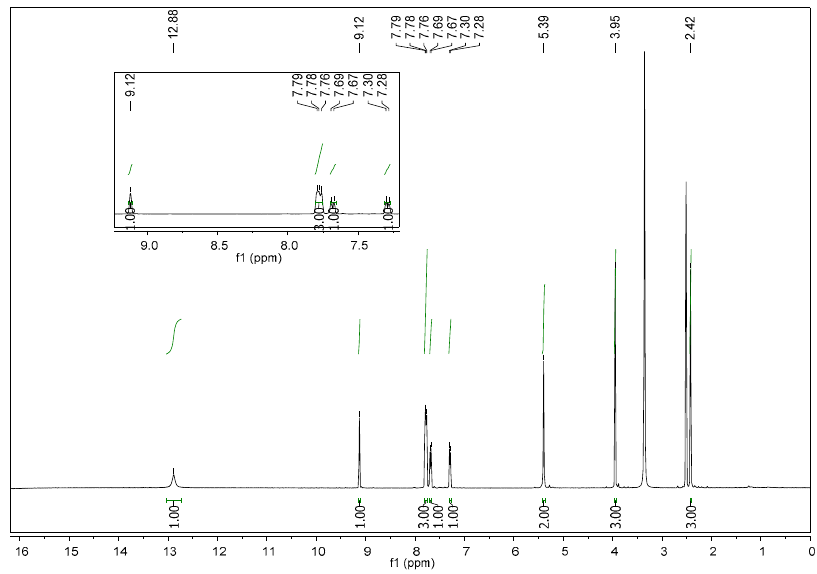
Figure 1. 1 H NMR spectrum of compound 10 .